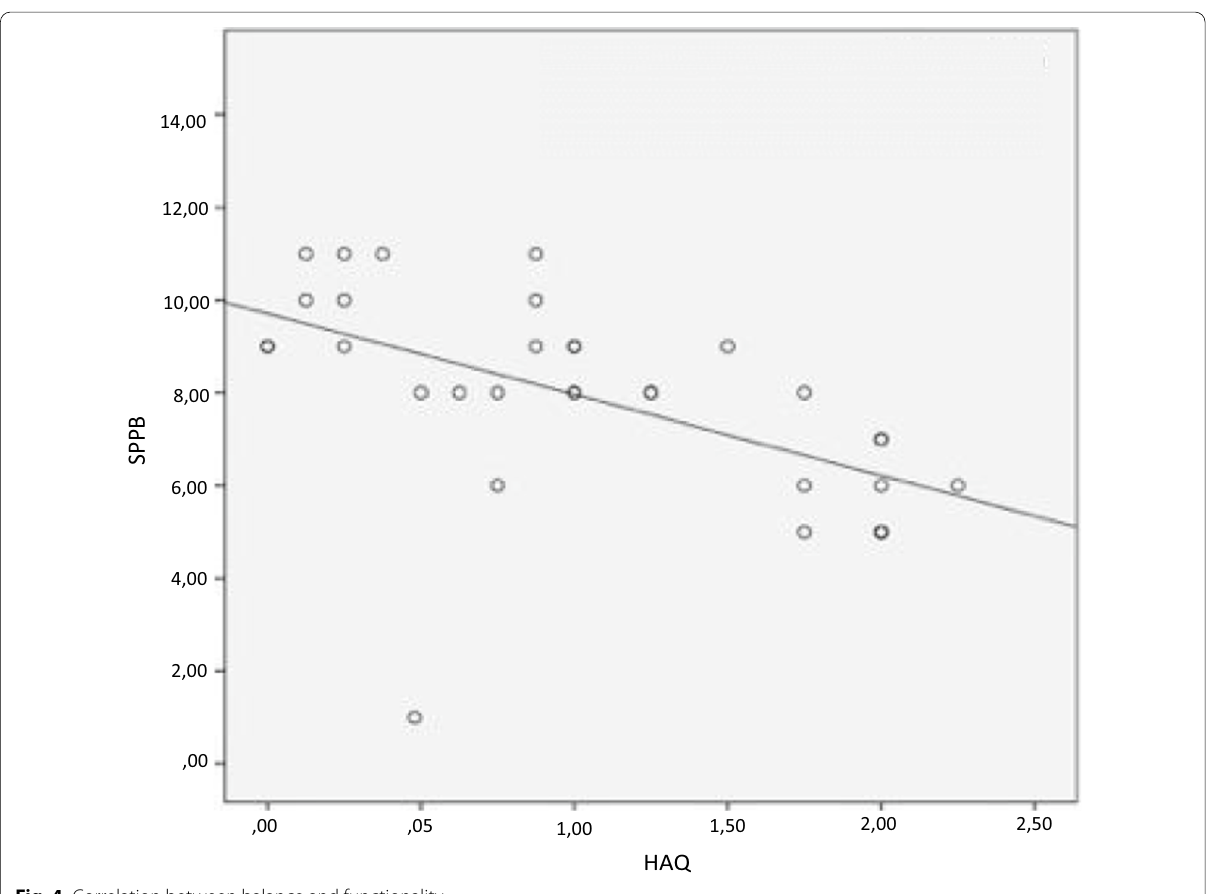
Fig. 4 Correlation between balance and